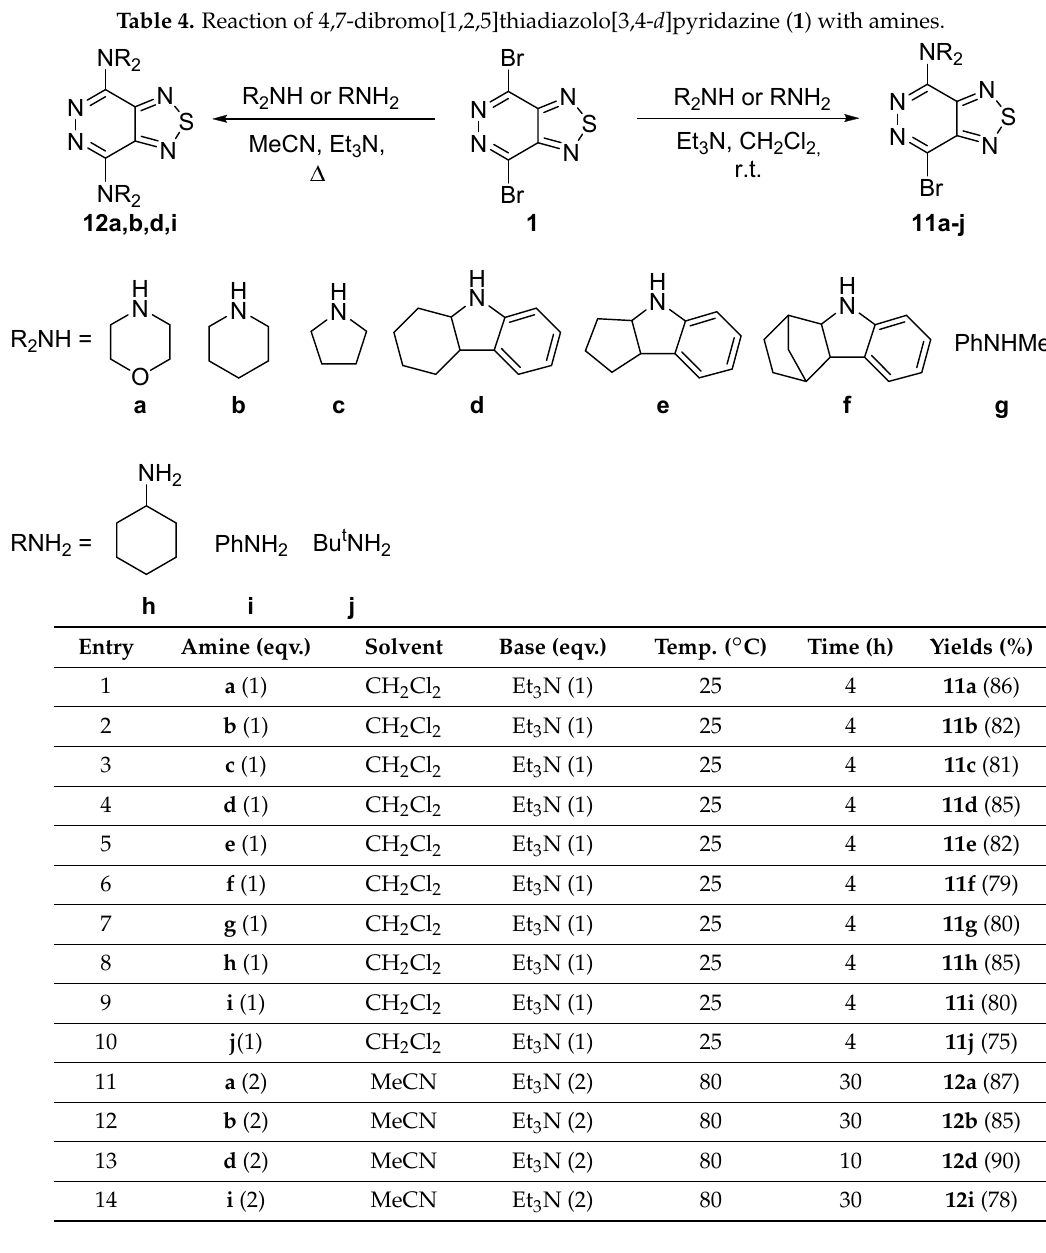
Molecules 2018 , 23 , x Table 4. Reaction of 4,7-dibromo[1,2,5]thiadiazolo[3,4- d ]pyridazine ( 1 ) with amines.